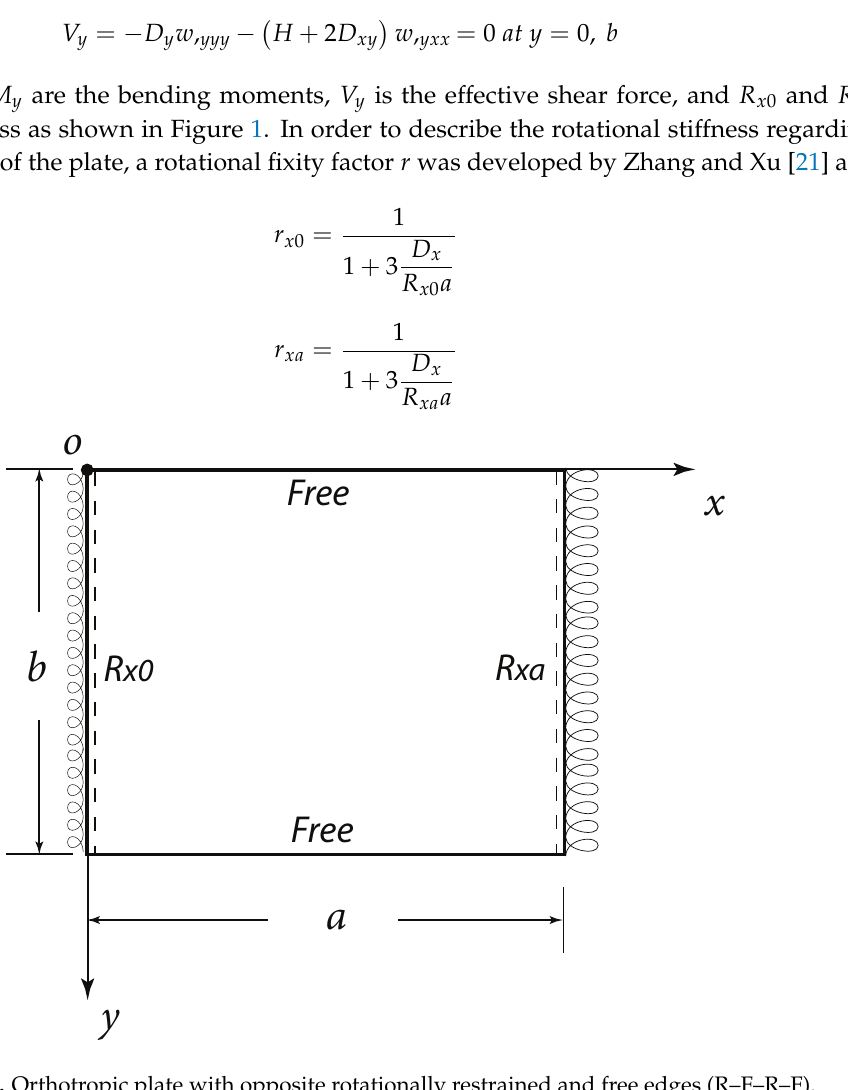
Figure 1. Orthotropic plate with opposite rotationally restrained and free edges